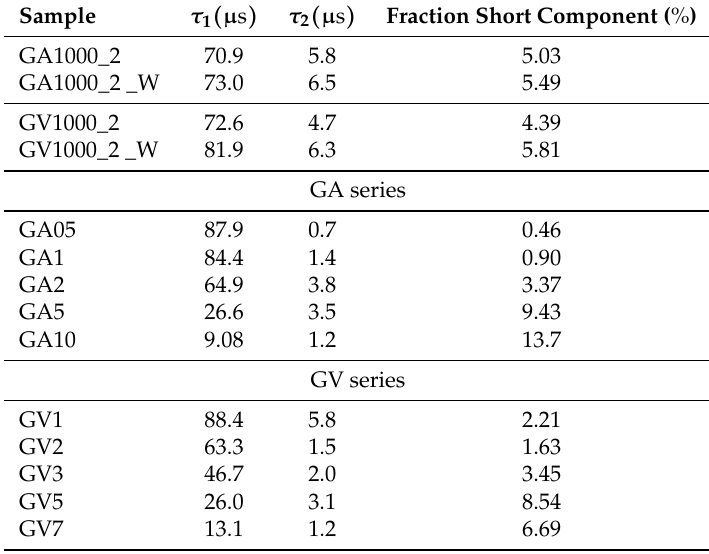
Table 3. Decay times of all the